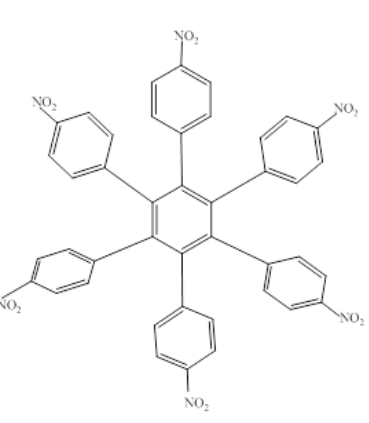
Figure 8. Structure of HAB4 .